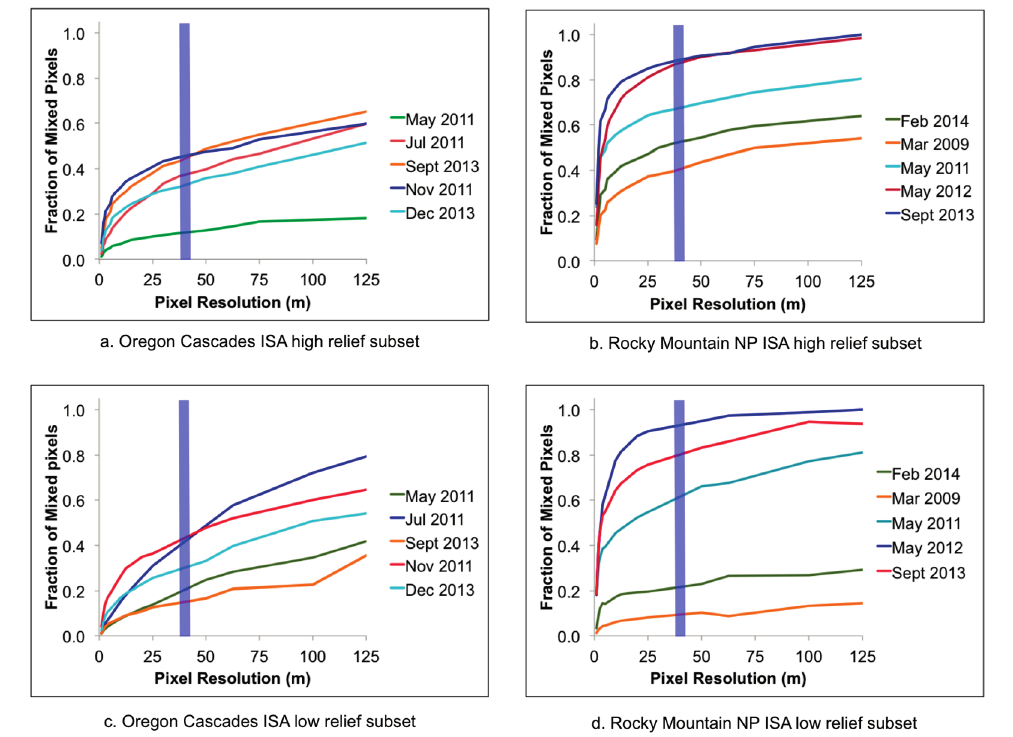
( b ) fraction of mixed pixels for the Rocky Mountain NP ISA high-relief subset, ( c ) fraction of mixed pixels for the Oregon Cascades ISA low-relief subset, and ( d ) fraction of mixed pixels for the Rocky Mountain NP ISA low-relief subset. Vertical blue lines indicate 40 m, slightly above the nominal spatial resolution of